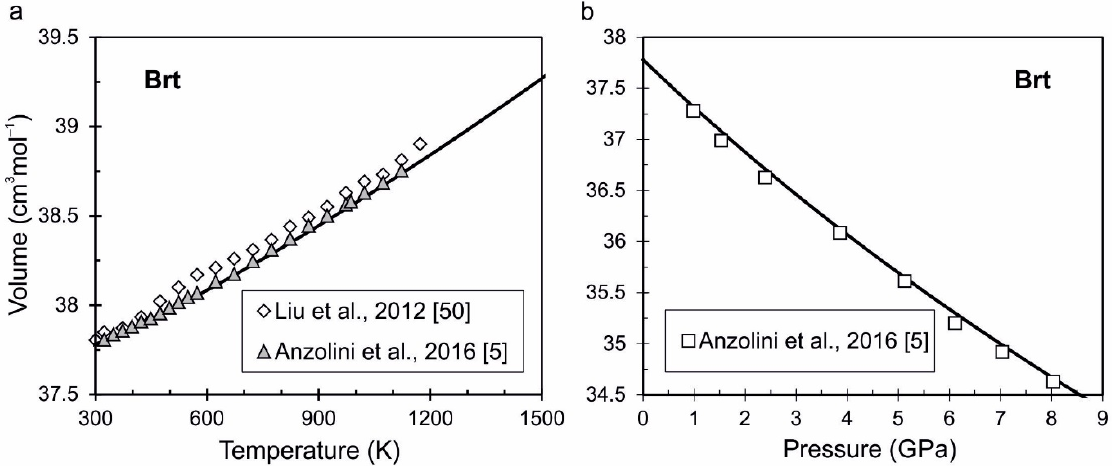
Figure 2. The calculated volume of breyite as a function of temperature ( a ) and pressure ( b ) is compared with experimental data from [5,50].